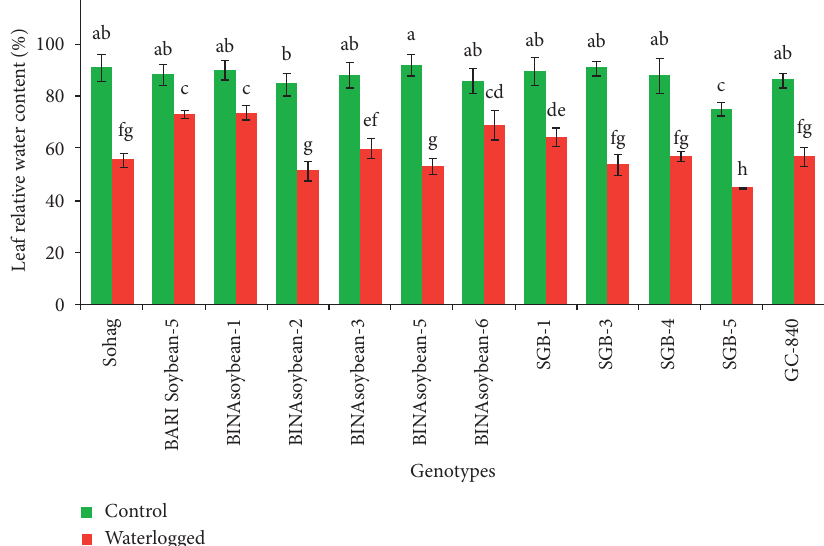
Figure 4: Effect of waterlogging stress on leaf relative water content (RWC) of different soybean genotypes. For each treatment, the mean ( ± SD) was determined from three replicates. Different alphabets on the bars indicate significant difference at P ≤ 0 . 05 after mean comparison by Fisher’s LSD test.